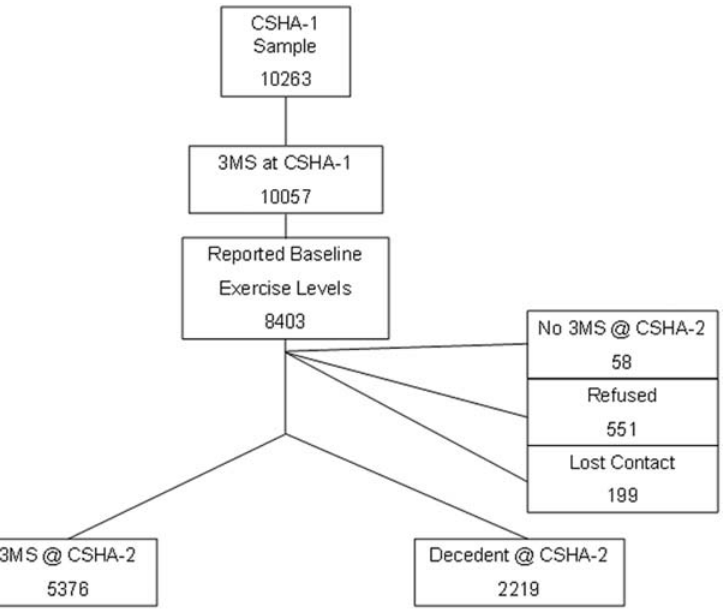
Figure 1. Selection of the study sample from the total CSHA-1 population, including those participants from CSHA-1 who completed the 3MS, reported exercise levels, and either completed the CSHA-2 3MS or died before follow up.